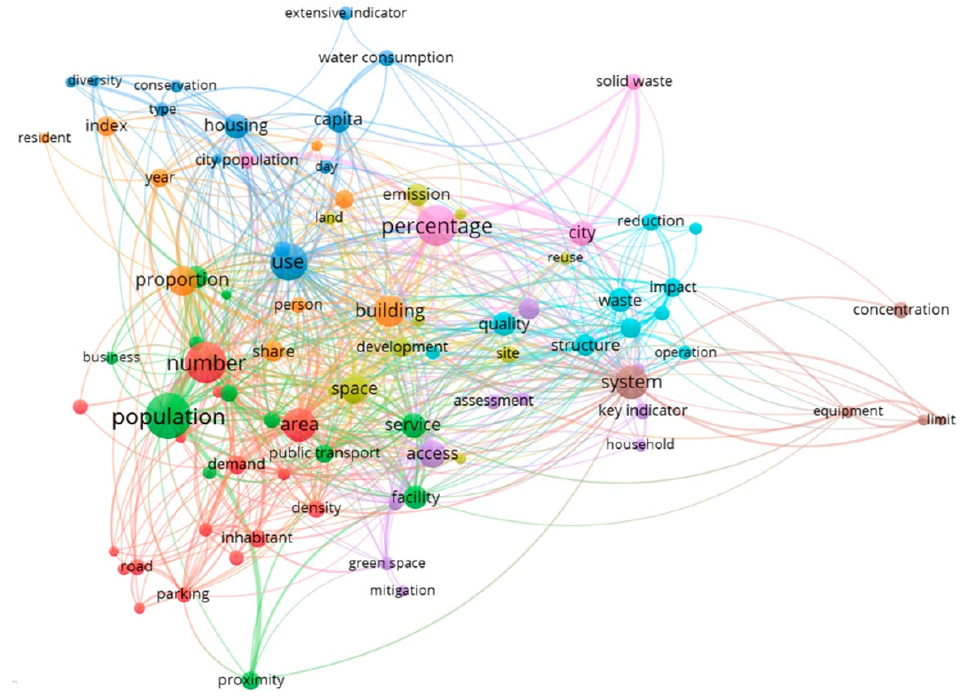
Figure 1. Visualization of the cluster network from the terms of sustainable urban indicators shown in Table 1 with a lower limit of co-occurrence of 7.